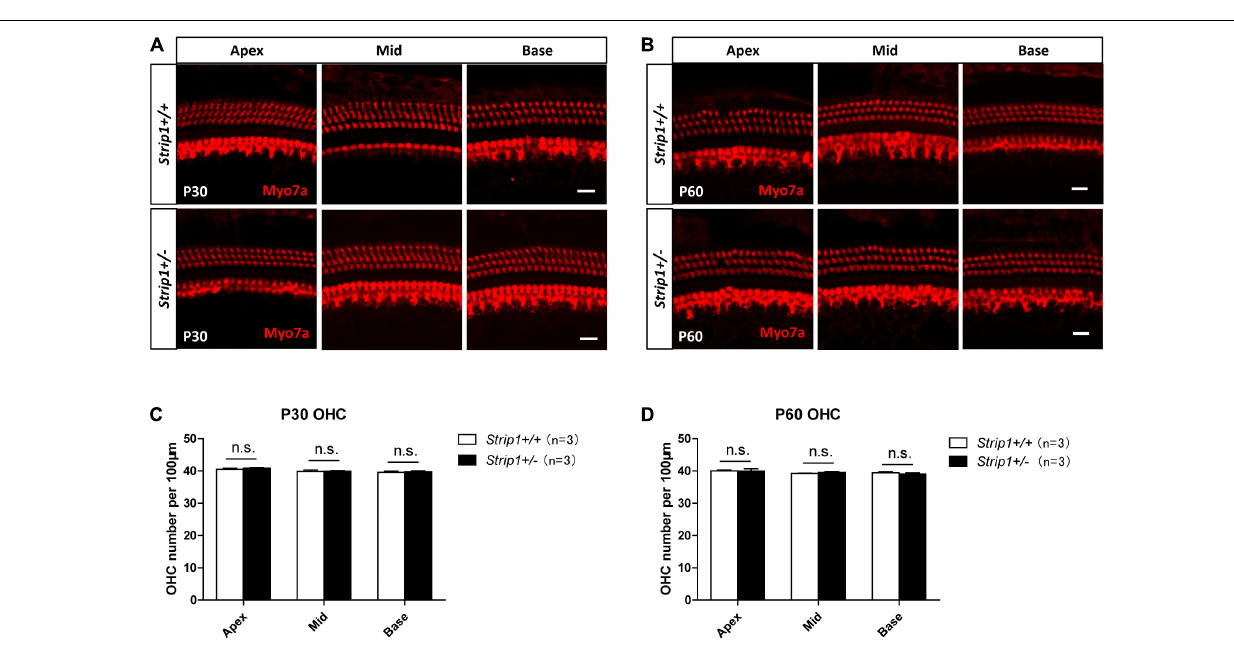
experienced arrested development at mid-gestation because of serious disruptions of the mesoderm and its derivatives (Bazzi et al., 2017), and this might be the cause of death of the Strip1 − / − mice in our